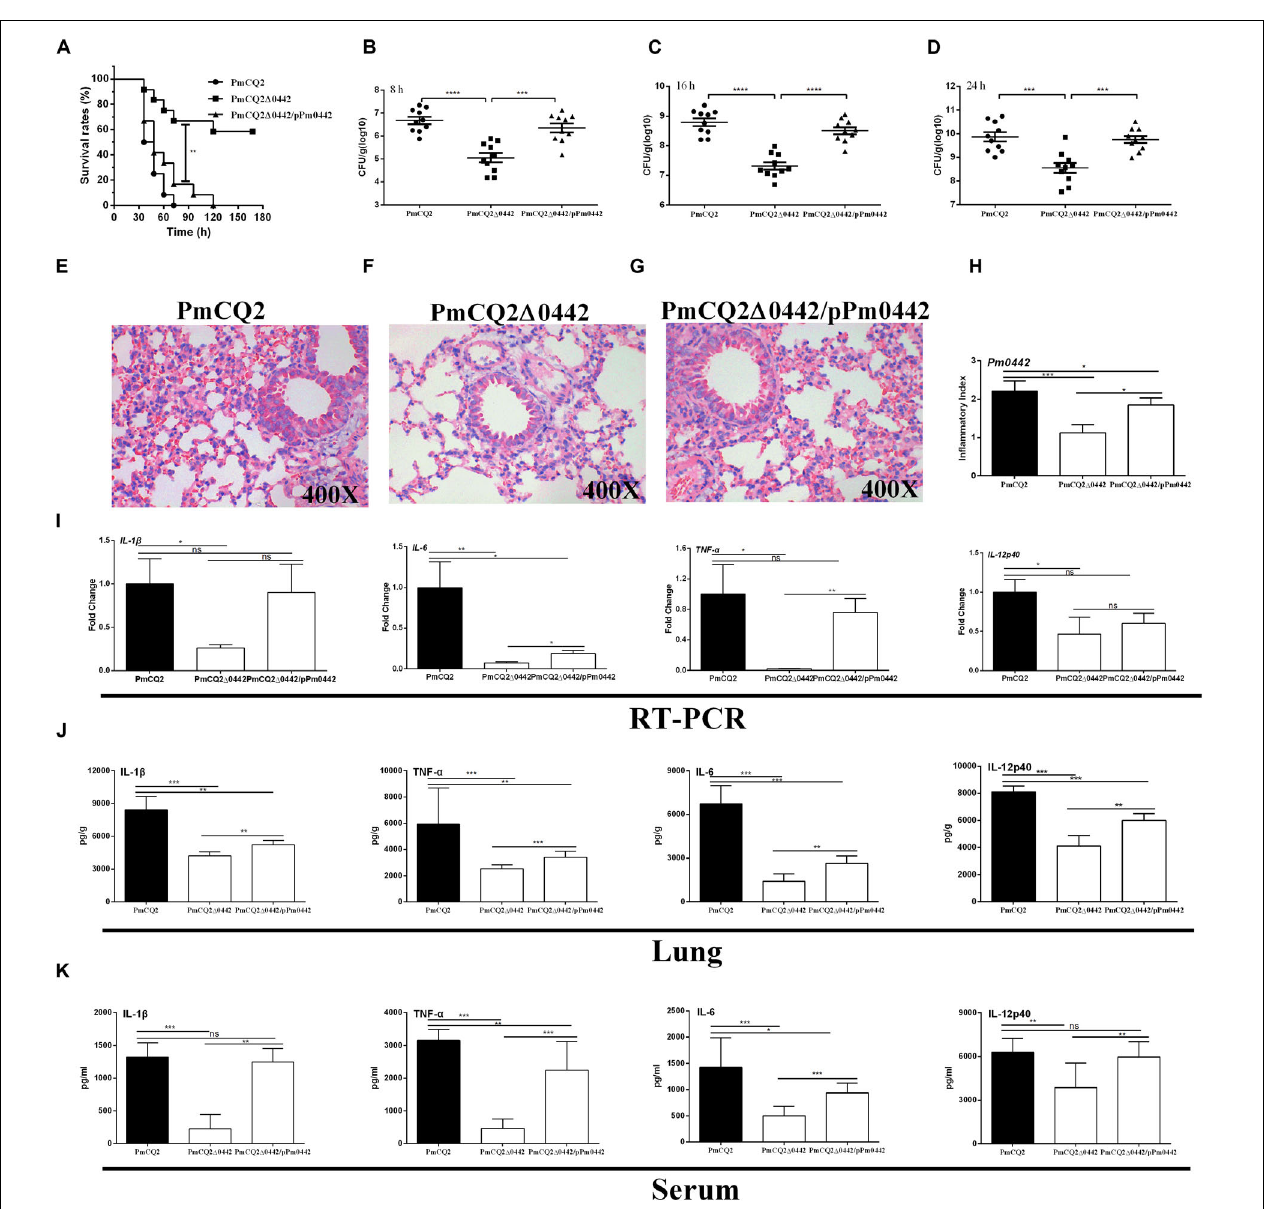
FIGURE 3 | PmCQ2 (cid:49) 0442 virulence. (A) Survival rates of mice as a function of time after infection. (B–D) Bacterial burdens in the lungs at 8, 16, and 24 h post-infection. (E–H) H&E staining of mouse lungs at 16 h post infection. (I–K) The mRNA expression (I) and the protein abundance of IL-1 β , IL17, IFN- γ , and TNF- α in the lung (J) and serum (K) of mice at 16 h post-infection. Panels (A–D) were pooled from three independent experiments with 10 replicates per group. Panels (E–I) were pooled from two independent experiments with 6 replicates per group. Panels (J,K) were pooled from two independent experiments with 8 replicates per group. Panel (A) was were determined by Log-rank (Mantel–Cox) test. Panels (B–D) were analyzed with unpaired t -test. Panels (H–K) were determined by one-way ANOVA, unpaired t -test or Mann–Whitney test. The data were expressed as means SD (* p < 0.05, ** p < 0.01, *** p < 0.001, **** p <